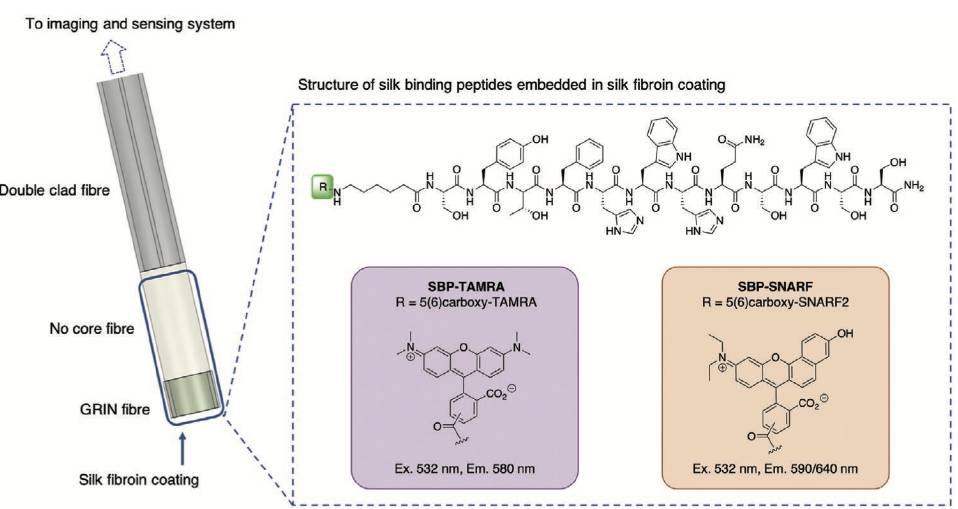
Figure 4. Silk-based functionalization of a DCF fiber probes for pH sensing. Image reprinted with permission from ref. [47]. Copyright 2021 Wiley-VCH